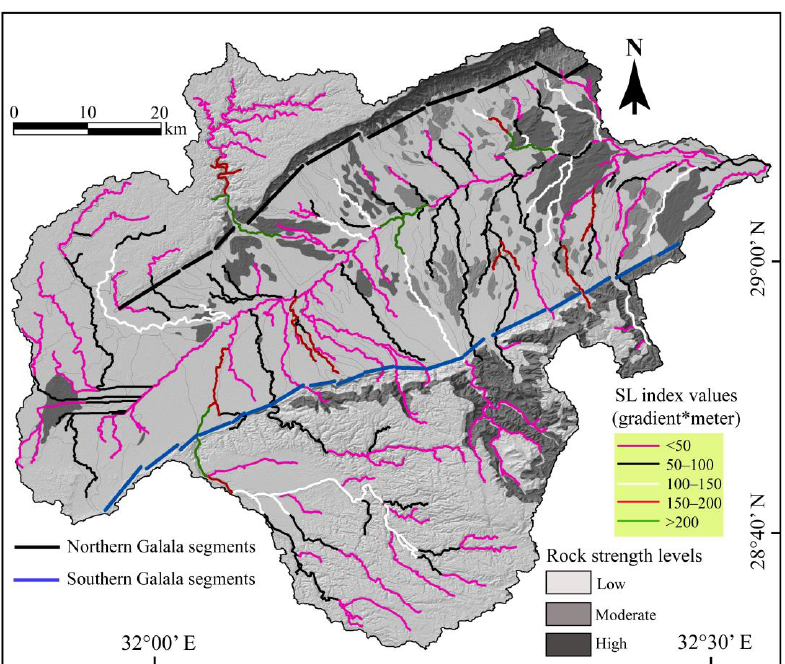
Figure 6. S L indices along the rivers and rock resistance levels according to the investigated basin. Table 1. Values of the mountain front sinuosity and valley floor width to valley floor height ratio of the study segments; the average classes of relative activity are presented as well. N: Northern Galala Plateau and S: Southern Galala